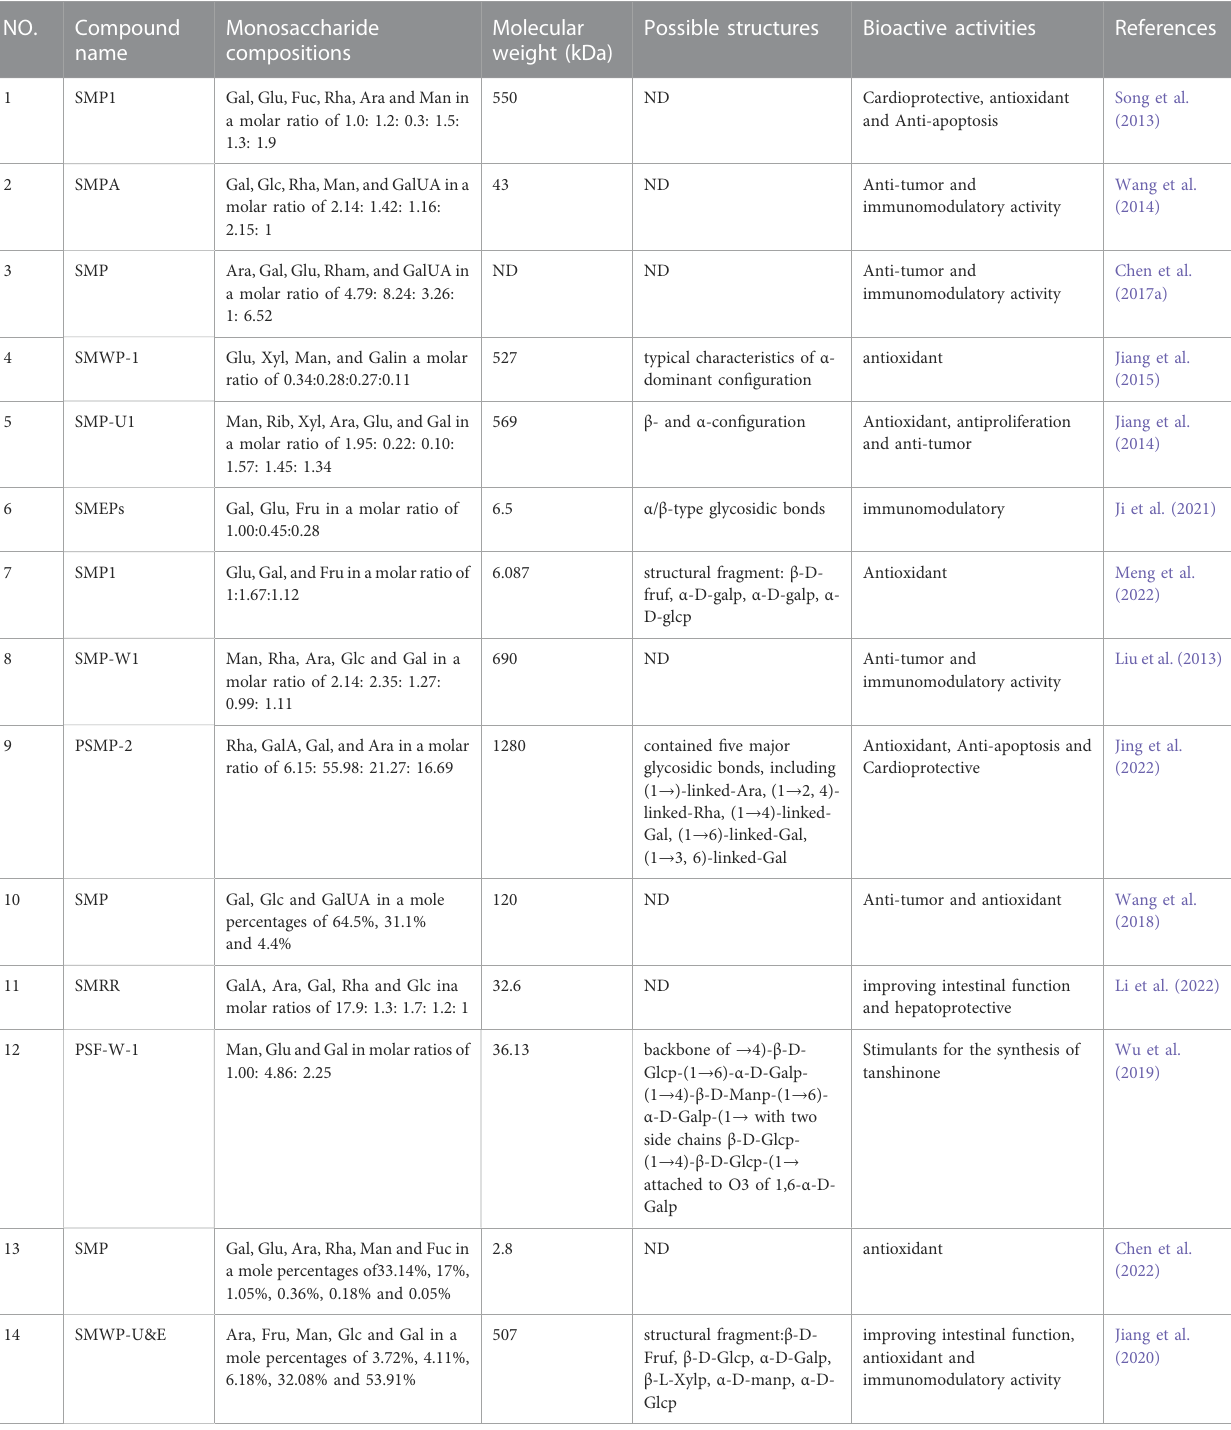
TABLE 2 Monosaccharide compositions, molecular weight, possible structures and biological activities of polysaccharides from Salvia miltiorrhiza.